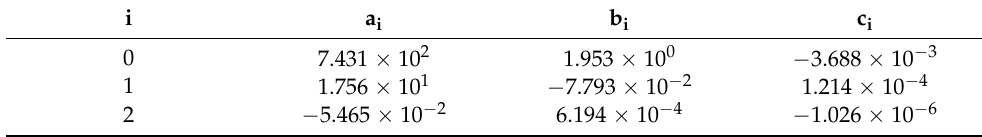
Table A22. Coefficients of the H 2 O-LiCl + LiNO 3 density